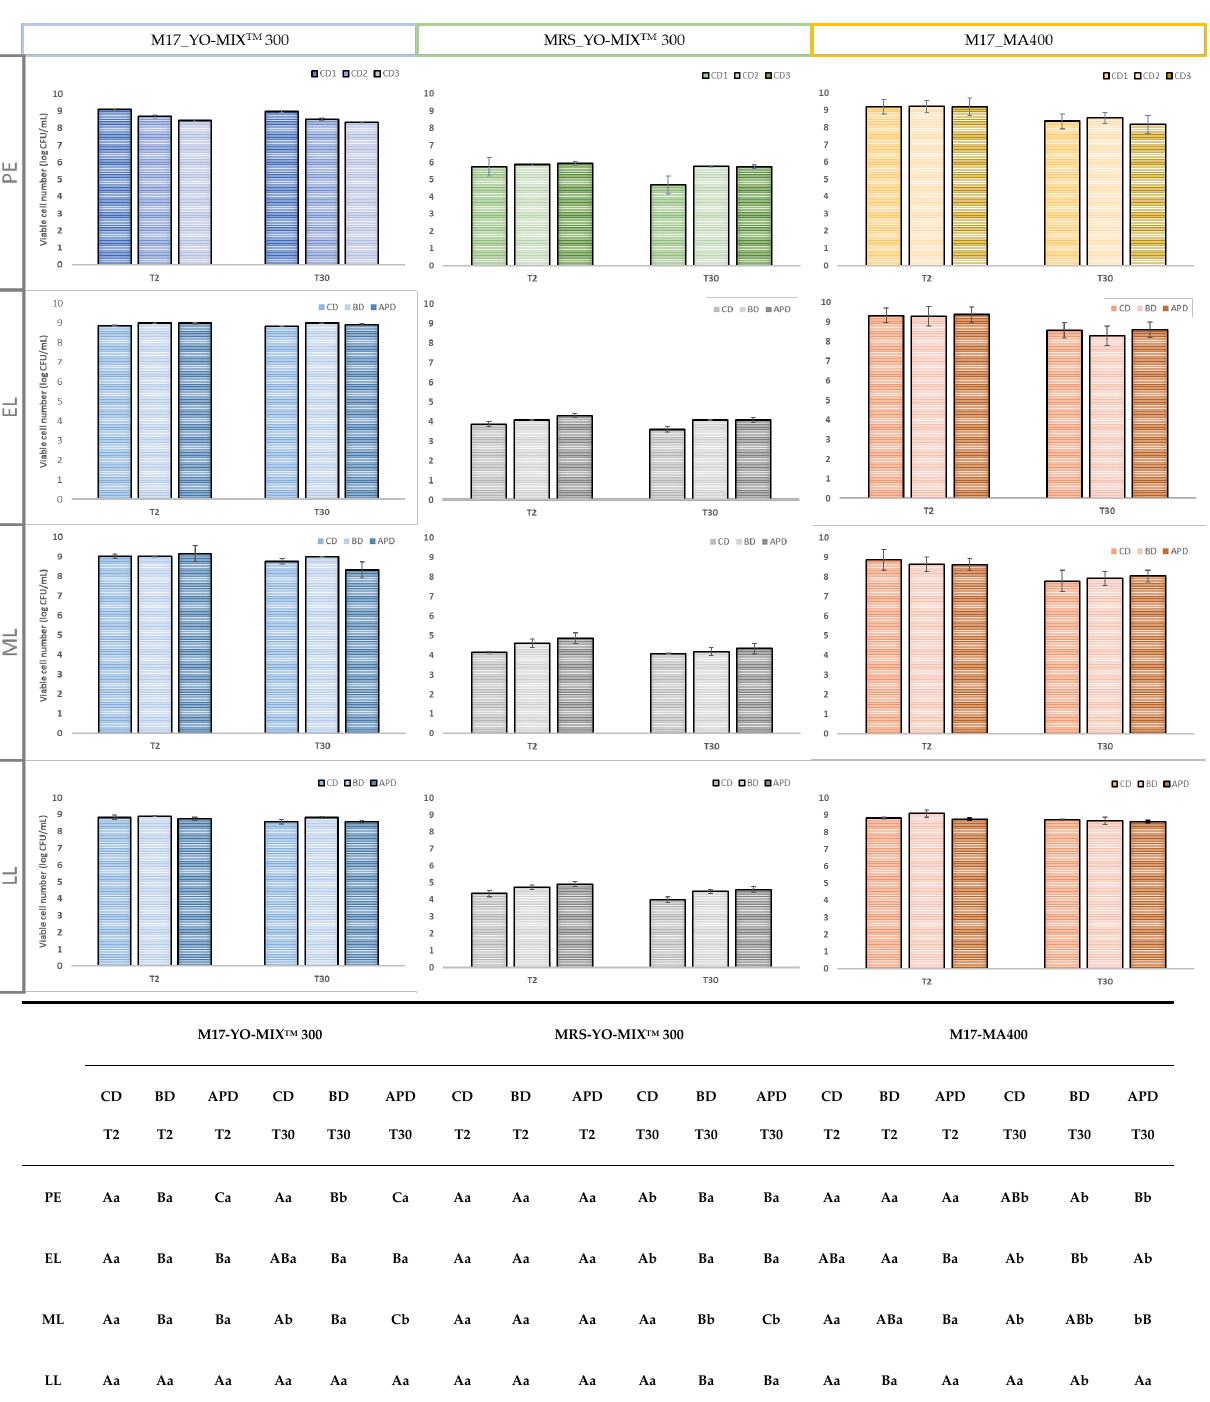
Figure 1. Lactic acid bacteria (viable cell number, log CFU/mL) of lactobacilli starter culture (YO- MIX TM 300 in MRS agar) and lactococci and streptococci (YO-MIX TM 300 and MA400 in M17 agar) in fermented milk with a storage time under refrigeration (T2 and T30). PE: Pre-experimental; EL: Early lactation; ML: Middle lactation; LL: Late lactation; CD1 Control diet; BD: Broccoli by-products diet; APD: Artichoke plant by-products diet. The lowercase letters refer to the differences between days (T2 and T30) of the same type of diet in each of the rows (production); Capital letters refer to the differences between diets at each of the times for each of the rows (production).